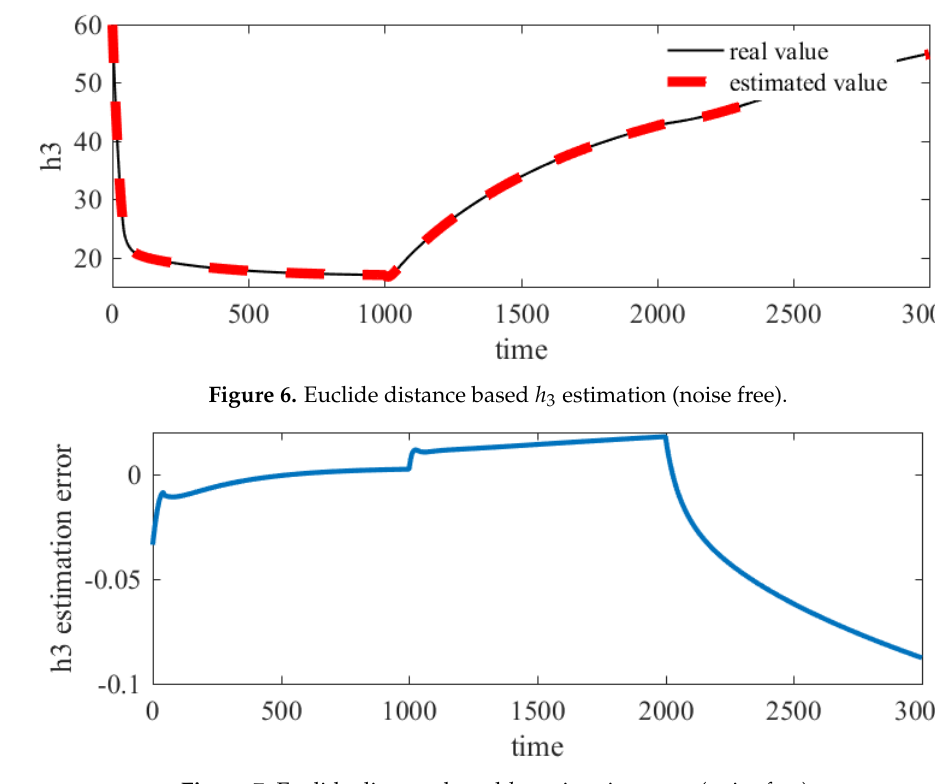
Figure 7. Euclide distance based h 3 estimation error (noise free).